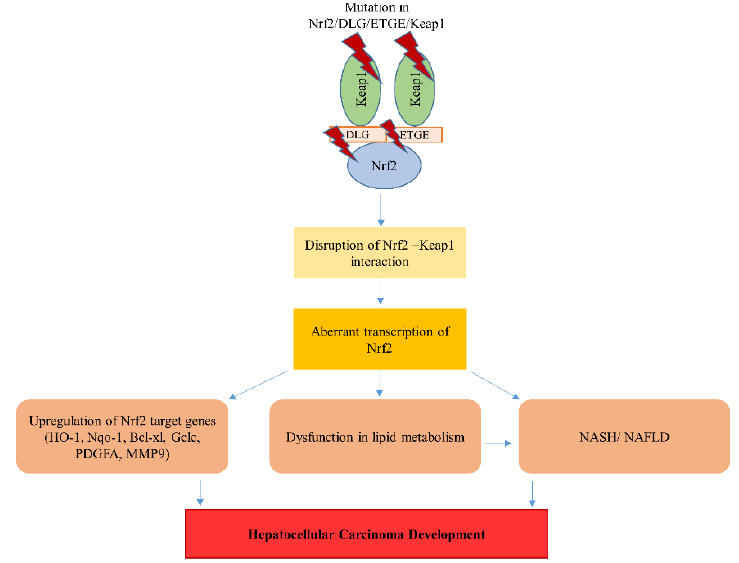
Figure 2. Mutations in NRF2 or Keap1 cause aberrant accumulation of NRF2 in the nucleus that leads to an increase in NRF2 target genes. This aberrant activation of NRF2 dysregulates the lipid metabolism responsible for the non-alcoholic steatohepatitis (NASH) / non-alcoholic fatty liver disease (NAFLD) pathology. Consequently, these events lead to the development of HCC.